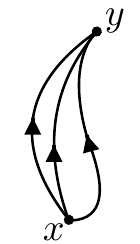
Figure 1 . Topological line operator U g ( M (1) ) supported on a manifold with boundary. Physical observables are invariant under deformation of the manifold M (1) stretching between x and y provided the boundary ∂M = { x, y } is held